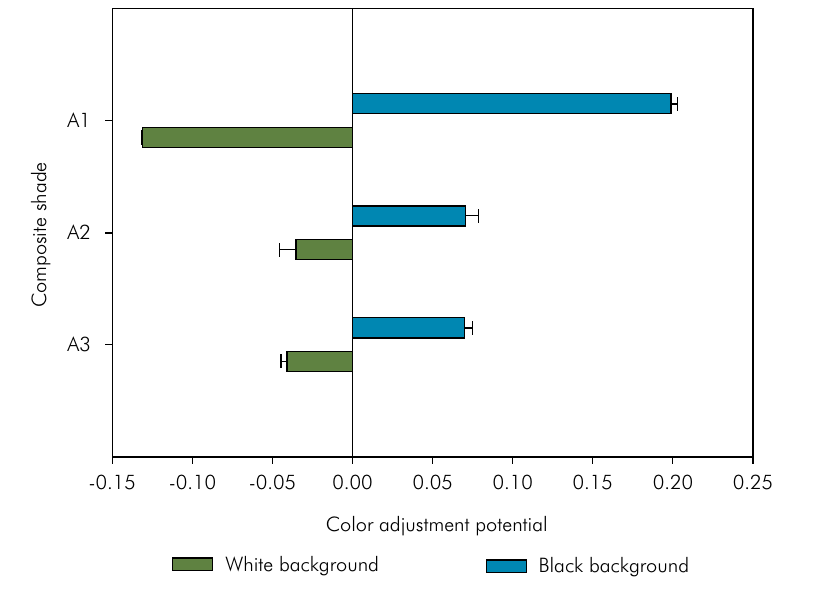
Figure 3. Means and standard deviations of the color adjustment potential (CAP) according to the composite shade and background